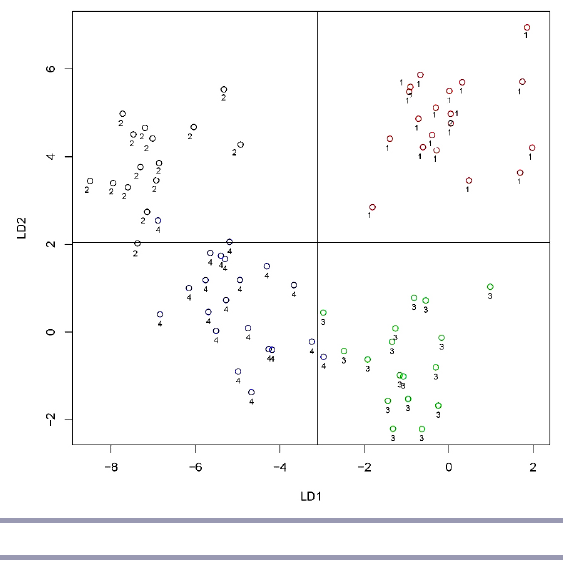
Fig. 3 . Scatterplot of first and second linear discriminant projections. 1 = Foreste Casentinesi, Monte Falterona e Campigna National Park (FCNP), 2 = Abruzzo, Lazio e Molise National Park (ALNP), 3 = Pollino National Park (PNP), and 4 = Aspromonte National Park (ANP).